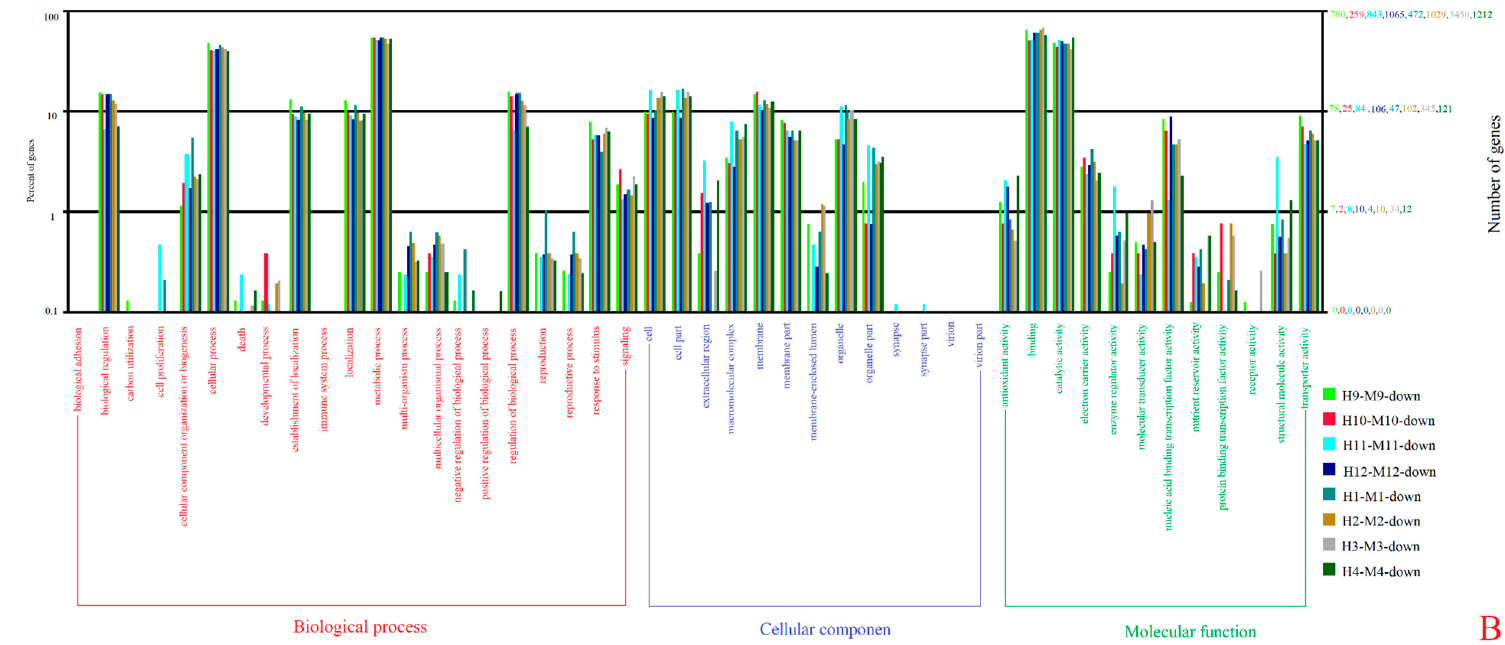
Figure 3. GO classification of unigenes: ( A ) upregulated genes and ( B ) downregulated genes.